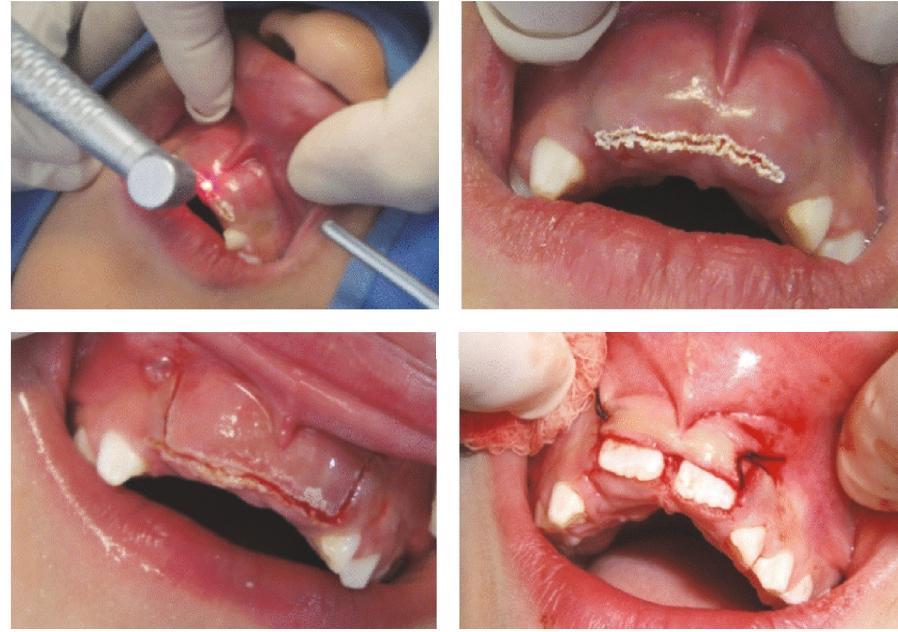
Figure 2: Surgical procedure stages.